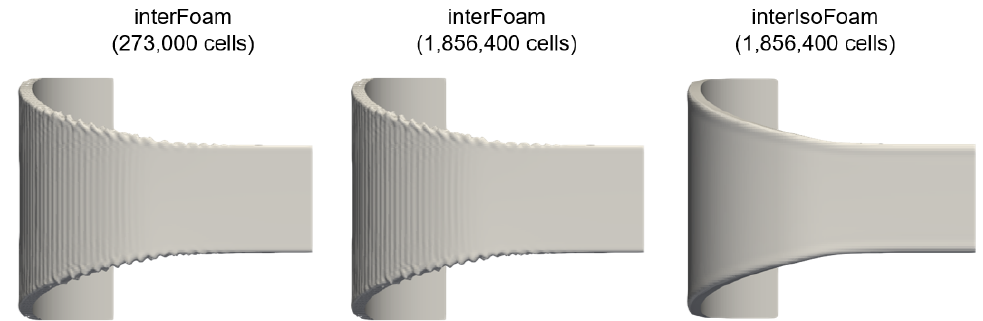
Figure 5. Polymeric sample geometry predicted by the modelling code, using different meshes and interface tracking approaches, at t = 2 s.